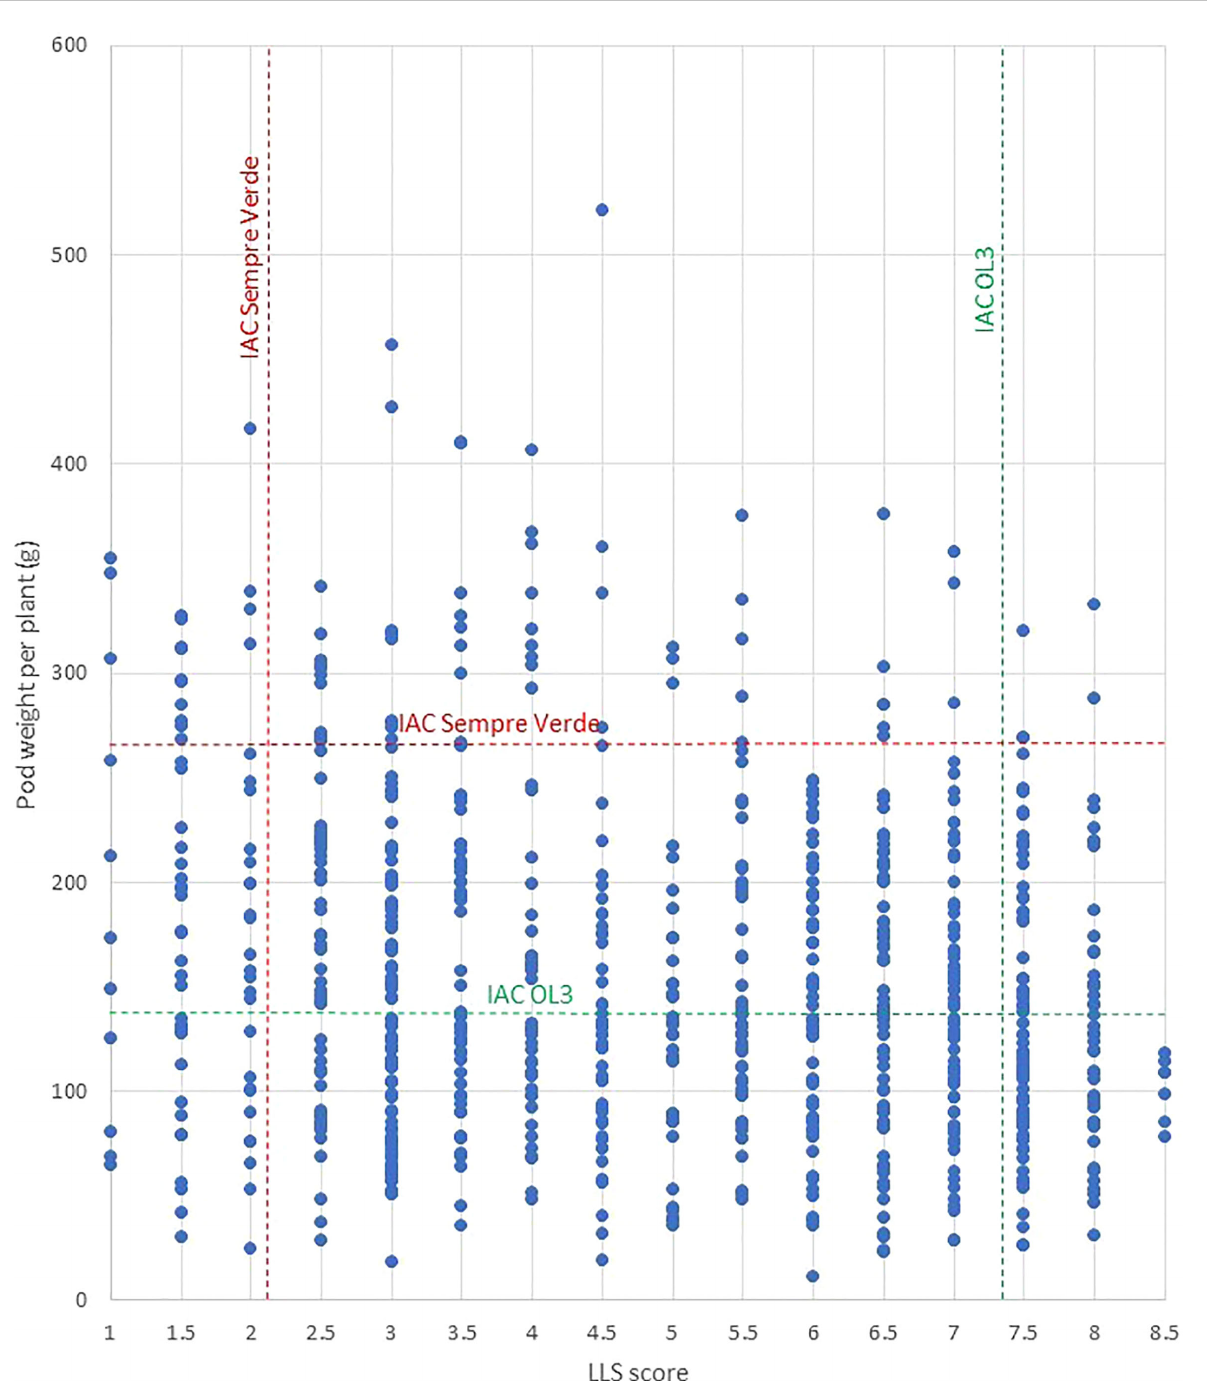
FIGURE 7 Pod weight produced and LLS score of each of the 808 plants of generations BC 3 F 2 , BC 3 F 3 , BC 3 F 5 , and BC 4 F 2 and the controls ‘ IAC Sempre Verde ’ (red) and ‘ IAC OL 3 ’ (green). No fungicide was sprayed on the four fi eld